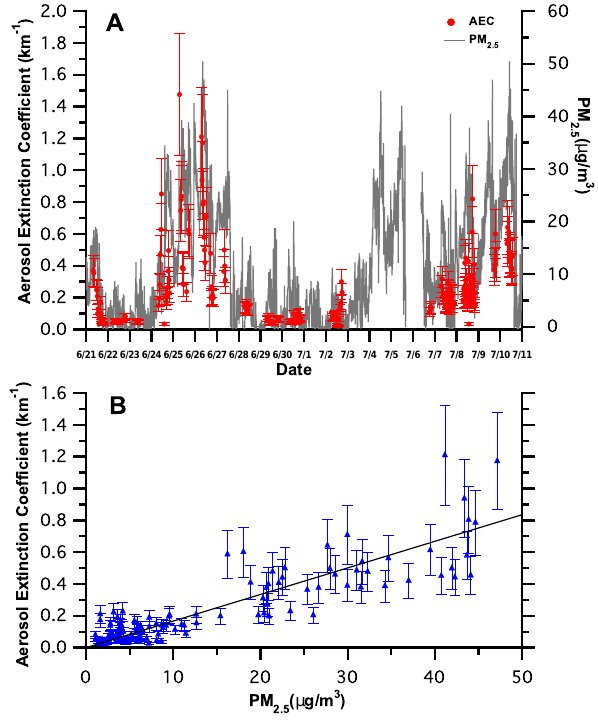
Fig. 6. Top panel (A) – aerosol extinction coefficient (red) and PM 2 . 5 (grey) at Ridgetown. Bottom panel (B) – PM 2 . 5 vs. aerosol extinction coefficient – Ridgetown. Slope of the trend line (y- intercept zero forced) = 16 ± 1 m 2 g − 1 , R 2 =